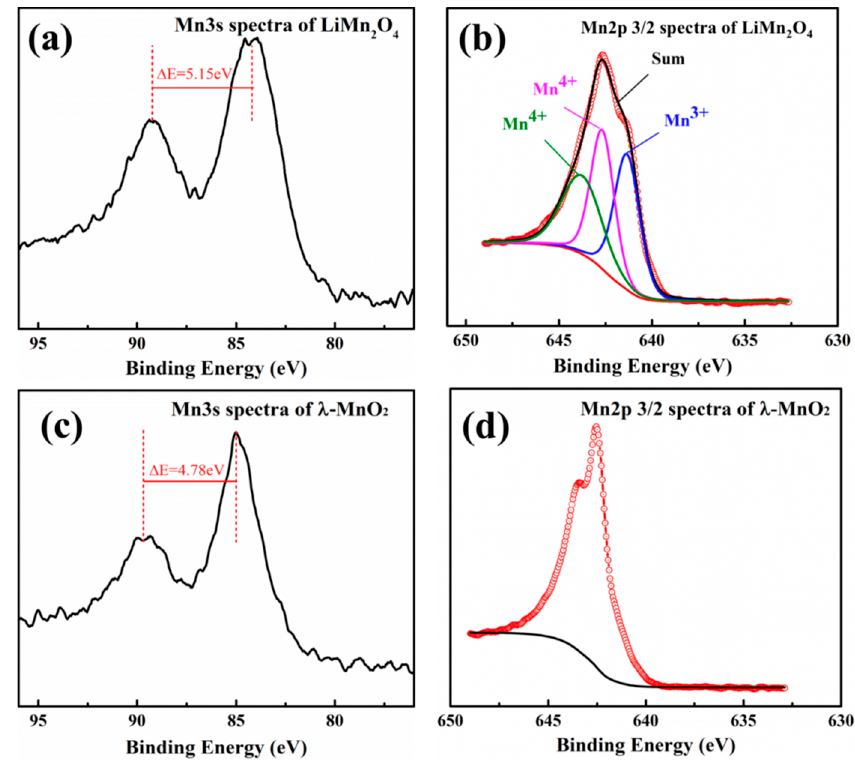
Figure 5. X-ray photoelectron spectroscopy (XPS) Mn3s and Mn2p spectra of LMO and HMO. Table 2. Average valances of Mn element in LMO and HMO.